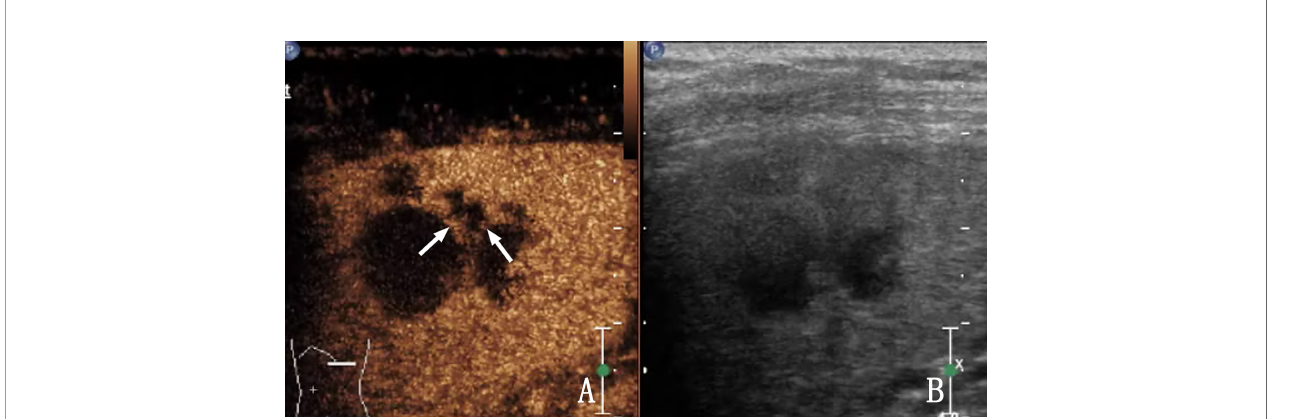
FIGURE 5 | A 28-year-old woman with splenic tuberculosis. (A) Contrast-enhanced ultrasound (CEUS) shows heterogeneous enhancement of the lesion within the spleen, and septal enhancement (arrow) can be observed. (B) Shows a two-dimensional ultrasound (2D